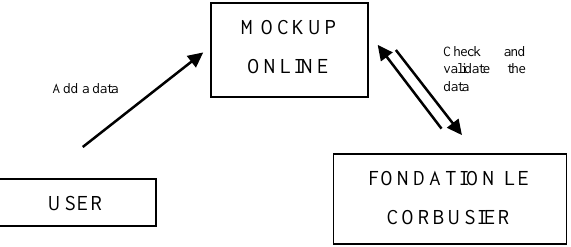
Figure17. Schematic diagram of the collaborative